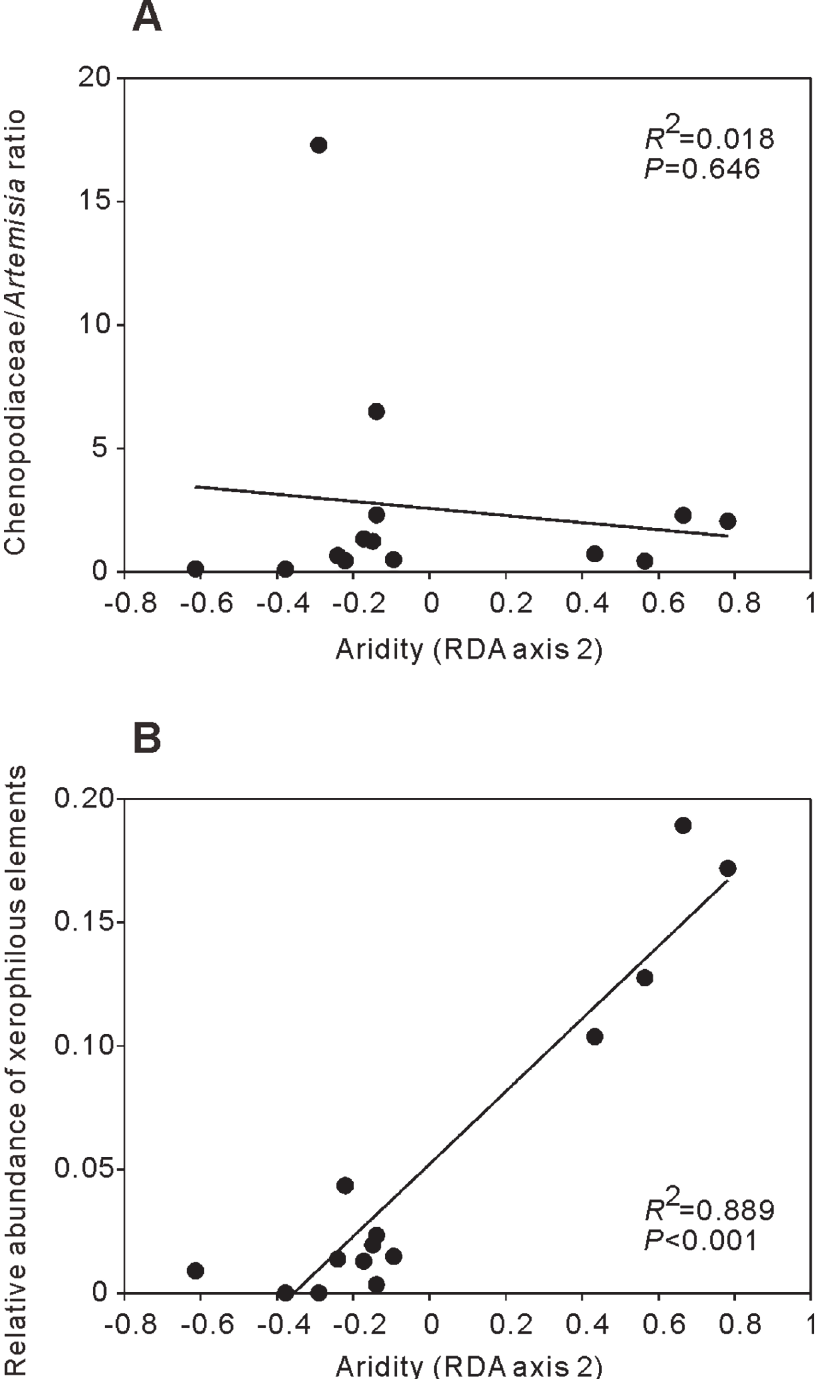
Fig 4. Scatter plots of C/A ratio (A) and the relative abundance of xerophilous elements (B) versus aridity gradient. Results of linear regression are shown ( R 2 , P and fitted lines).